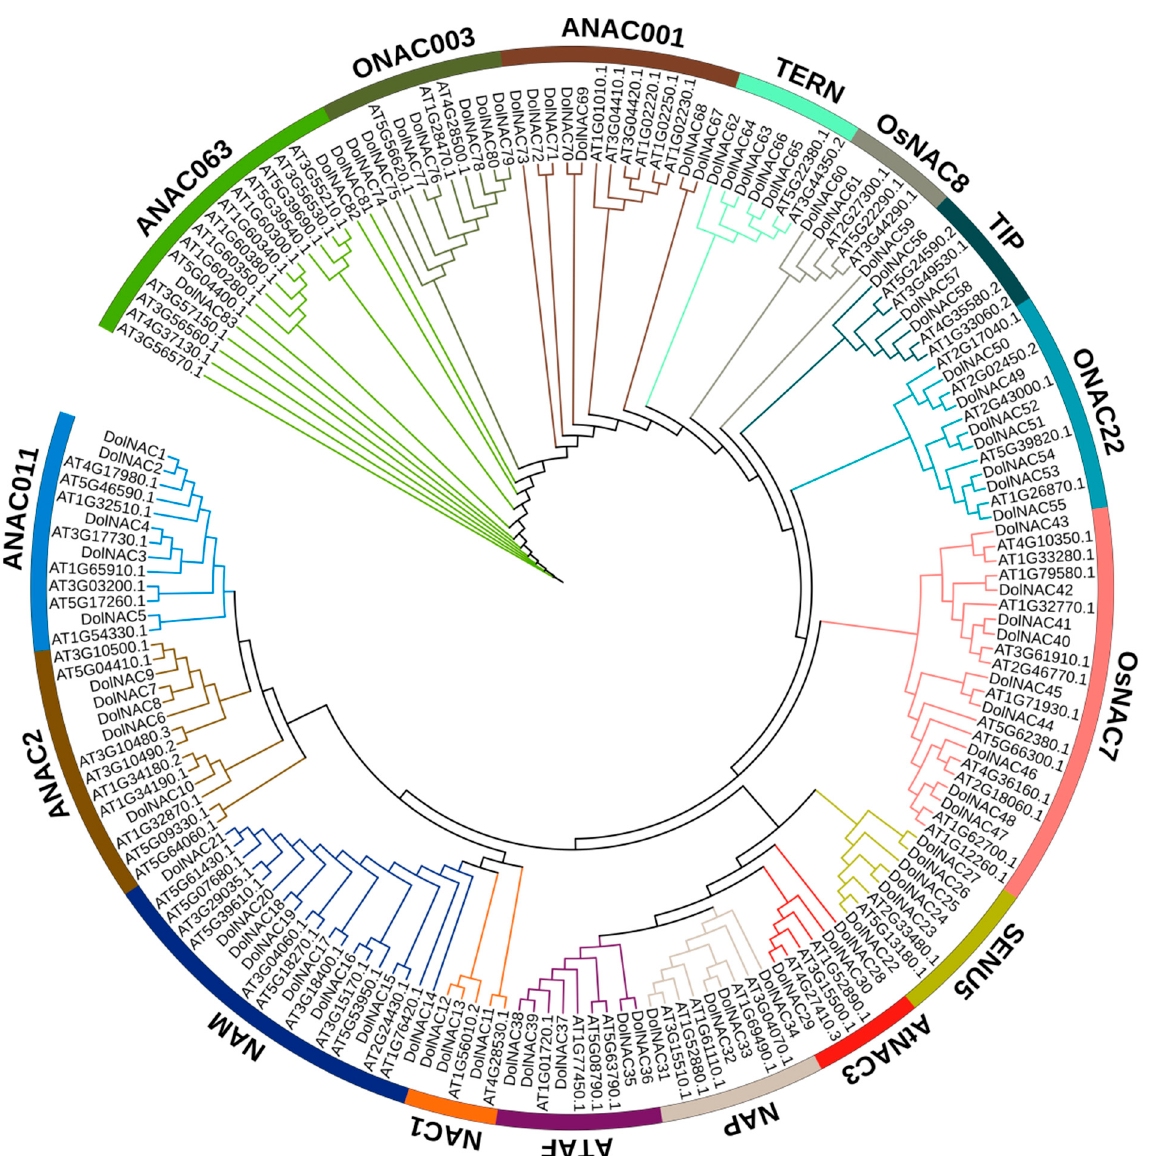
Figure 7. Phylogenetic tree showing the NAC genes in D. oleifera . The tree was visualized with the iTOL program. Different colours represent different groups.